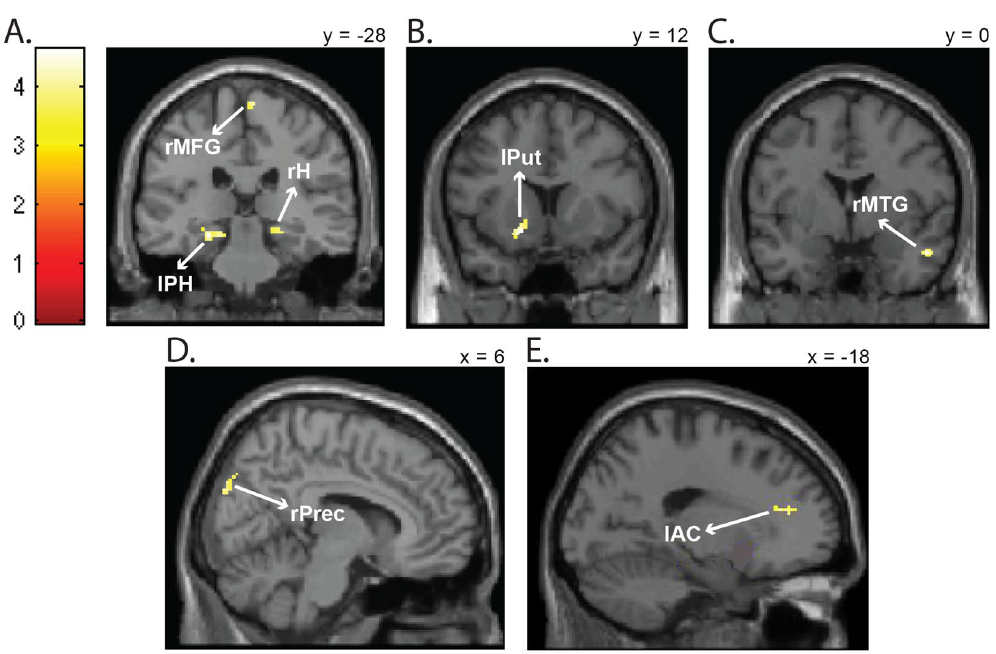
Figure 3. Emotion-action binding effect. Brain areas significantly ( p < 0.001, cluster corrected at p < 0.05) more activated for a complete repetition of the emotion and motor response than for a partial repetition of them, as shown by the complete repetition > partial repetition t-contrast. ( A ) Activation of the right medial frontal gyrus (rMFG), the left parahippocampal gyrus (lPH) and the right hippocampus (rH). ( B ) Activation of the left putamen (lPut). ( C ) Activation of the right middle temporal gyrus (rMTG). ( D ) Activation of the right precuneus (rPrec). ( E ) Activation of the left anterior cingulate gyrus